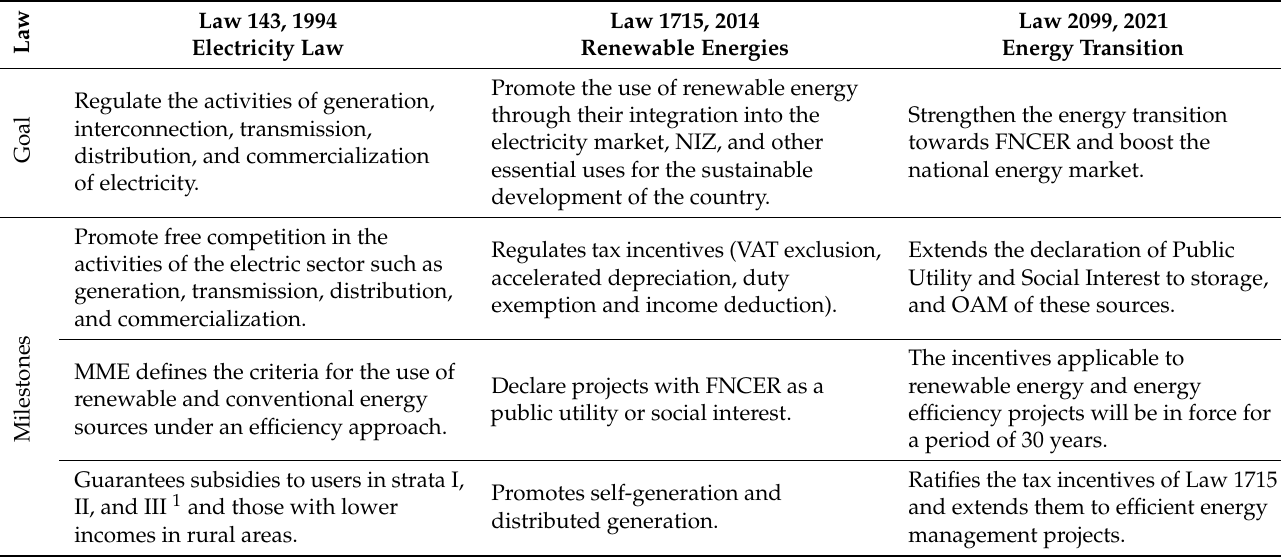
Table 1. Electricity sector laws: summary.